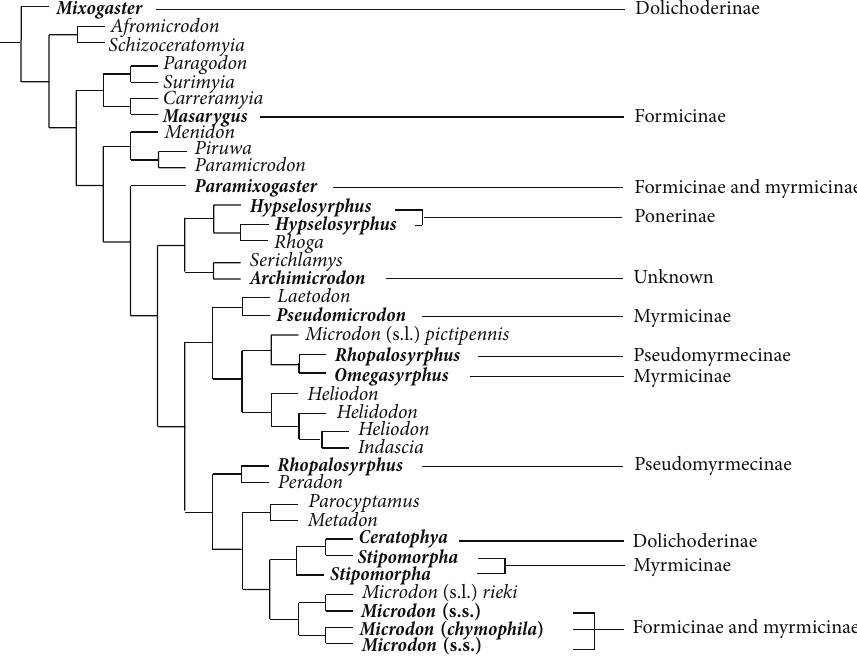
Figure 1: Phylogenetic hypothesis of 28 genera of Microdontinae (based on [28]), with indication of known associations with subfamilies of ants. Genera for which such associations are known are printed in bold. Note that several associations listed in Table 1 are lacking, because several taxa of Microdontinae were not included in the molecular dataset of [28].